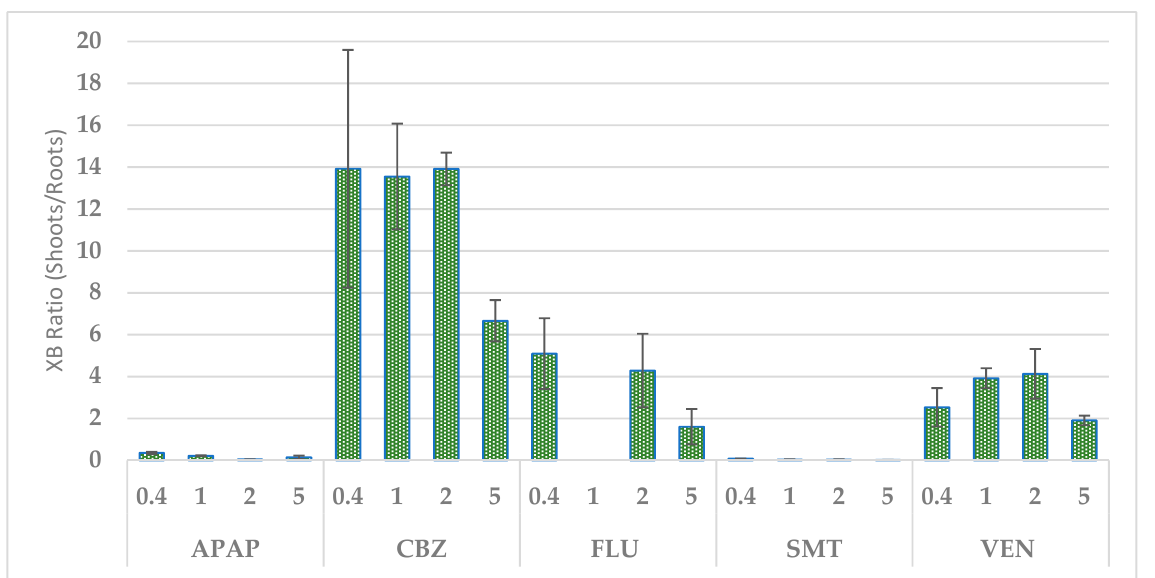
Figure 4. Xenobiotic concentration ratio in the plant biomass. APAP = acetaminophen; CBZ = carbamazepine; FLU = fluoxetine; SMT = sulfamethazine; VEN = venlafaxine. The values 5 and 2 on the X axis represent the singly xenobiotic concentration in the culture medium in mg L − 1 , and the values 1 and 0.4 represent each xenobiotic concentration in a mixture of the 5 xenobiotics in mg L − 1 . Columns show average ± standard error of three biological replicates per treatment.